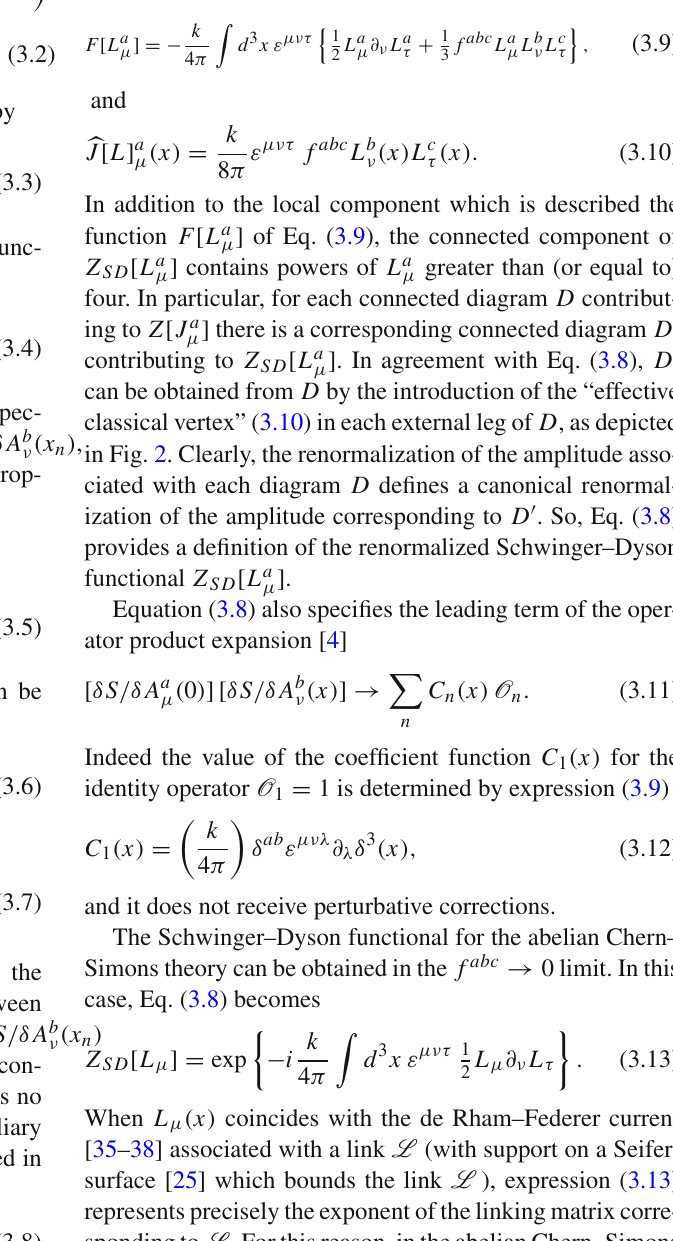
Fig. 2 Diagram D and the associated diagram D (cid:15) contributing to Z SD